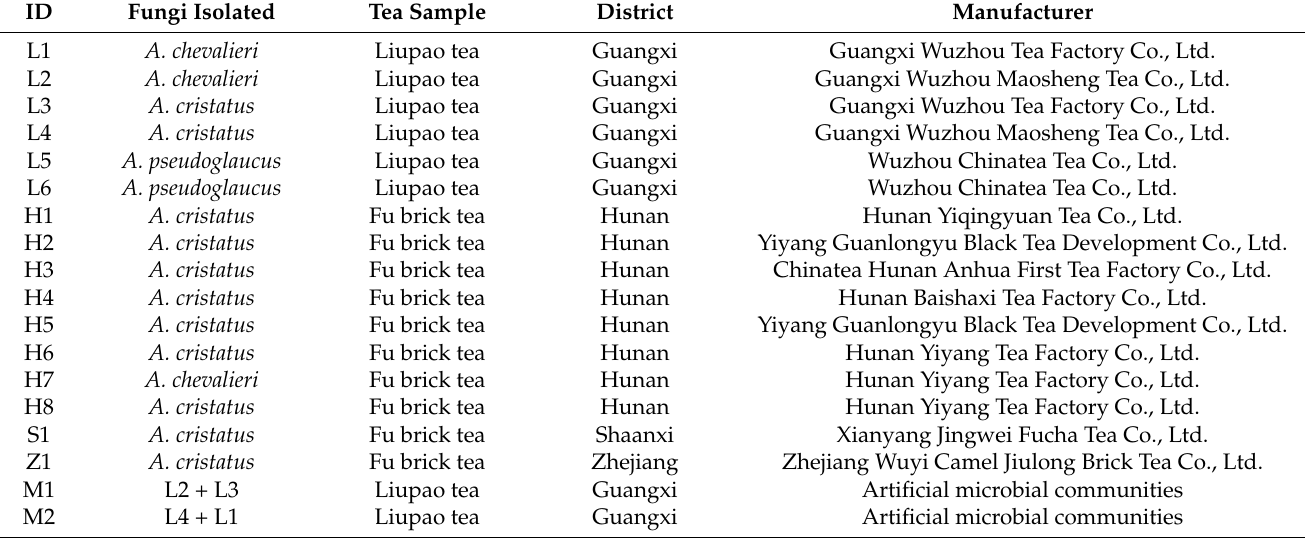
Table 1. “Golden flower” Fungi identified and tea samples information.